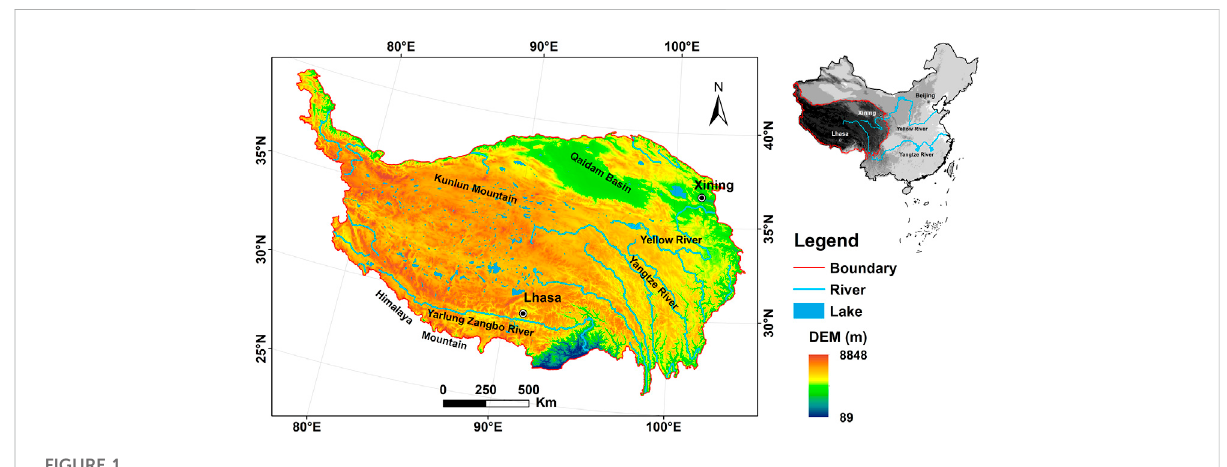
FIGURE 1 Location and elevation of Qinghai-Tibet